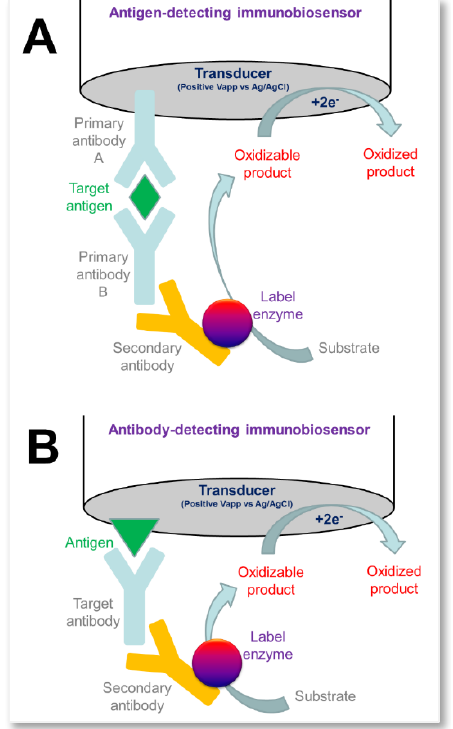
Figure 5. Examples of immune-biosensors that use an enzyme as label element for the indirect detection of a target antigen (panel A) or a target antibody (panel B). These bio-electrochemical reactions are carried-out in a controlled environment without matrix-related